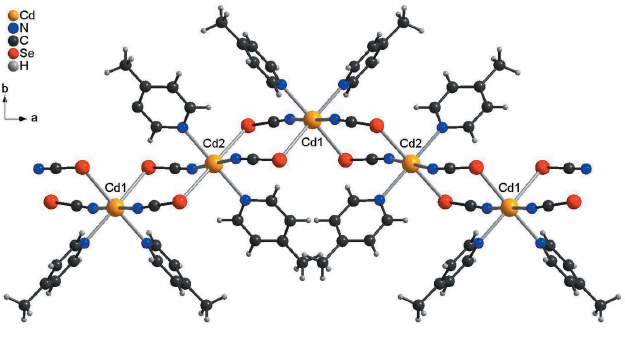
Figure 3 View of part of a chain in the crystal structure of compound 2 showing the alternating cis – cis – trans and all - trans